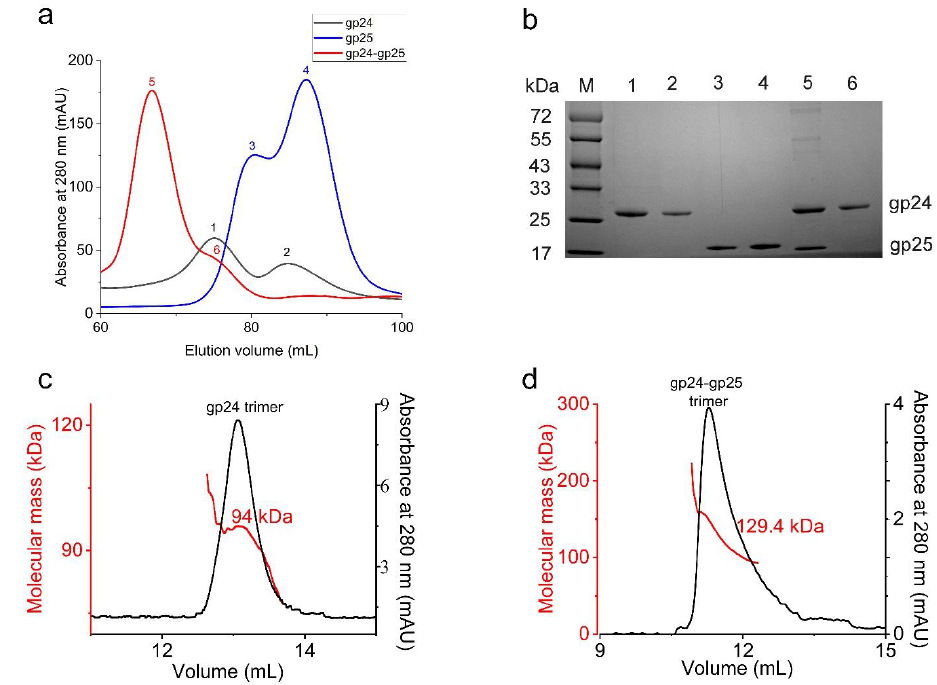
Figure 1. The purification of gp24, gp25 and the gp24-gp25 complex. ( a ) The size-exclusion chroma- tography profiles of gp24 (black line), gp25 (blue line) and gp24-gp25 complex (red line) using a Superdex 200 Increase 10/300 column. The corresponding peaks are labeled sequentially (1~6). ( b ) The SDS-PAGE analysis of the peaks from a . The samples were boiled for 10 min before loading to the SDS-PAGE. The gp25 protein in the gp24-gp25 complex has no tag, whereas the gp25 alone contains a His 6 -tag. ( c , d ) show the SEC-MALS analysis of the gp24 trimer and the gp24-gp25 complex. The black line represents the absorbance at 280 nm ( Y -axis on the right), and the red line indicates the molecular weight ( Y -axis on the left).